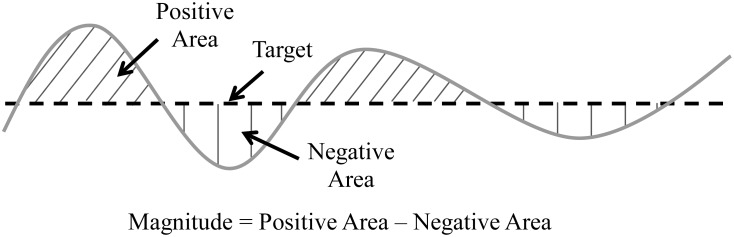
Torque magnitude example calculation.Torque magnitude was calculated as the difference between the positive area and negative areas of the knee flexion torque relative to the target.